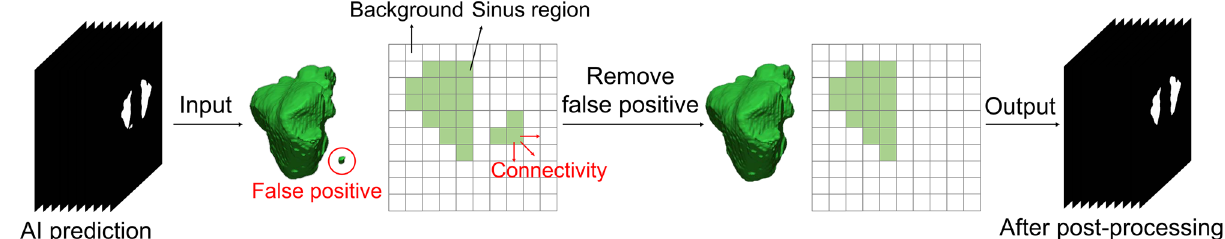
Figure 4. The post-processing workflow. False positives not connected to the maxillary sinus were features were extracted, and then the size of feature maps was recovered to be the same as the input. The deep learning networks were implemented in Python 3 with the Keras library and trained on an NVIDIA Titan RTX (24 GB).